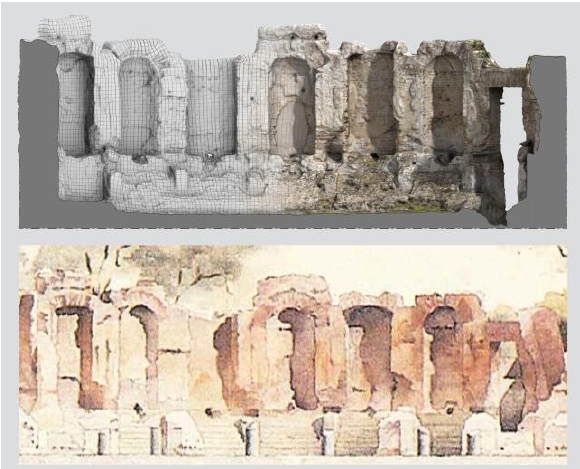
Figure 15. A comparison between the southern nymphaeum of the Piazza d’Oro represented using textured displaced subD and a traditional drawing made Charles-Louis Girault